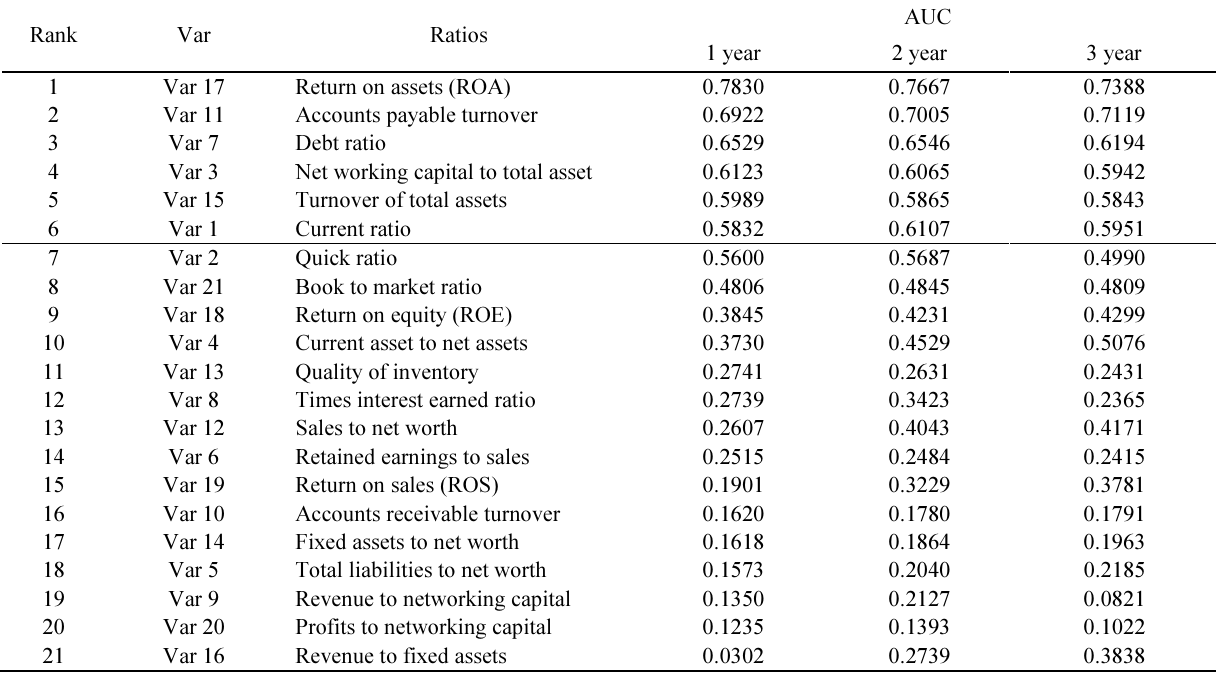
Table 3. The result of AUC of 21 univariate Logit models in 1, 2, 3 year ahead bankruptcy prediction Rank